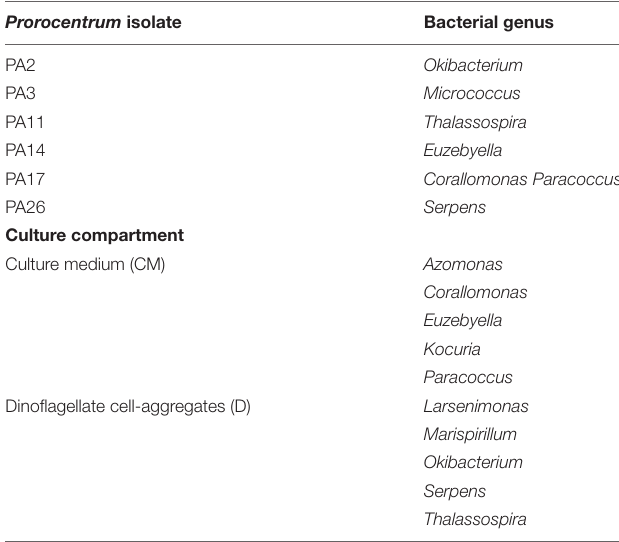
TABLE 3 | Bacterial genera isolated exclusively from specific Prorocentrum isolates and culture compartments: Prorocentrum cell aggregates versus surrounding